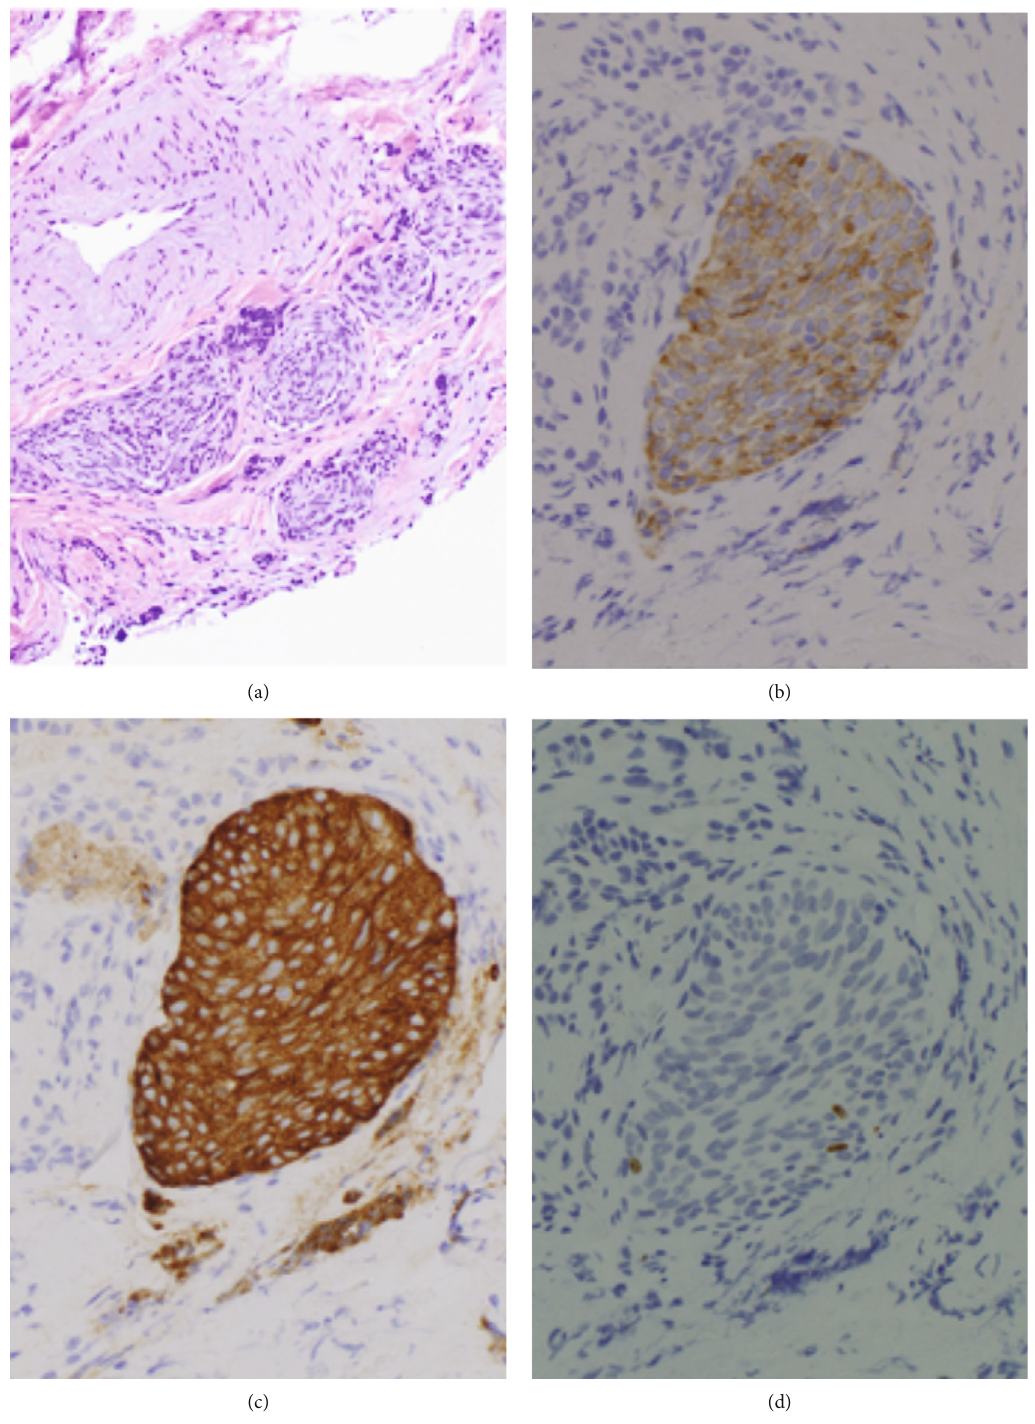
Figure 3: (a) H&E stain of the medial right middle lobe nodule. (b) Medial right middle node nodule with chromogranin-positive pathology, a neuroendocrine marker. (c) Medial right middle lobe nodule with synaptophysin-positive pathology, another marker for neuroendocrine cells. (d) Medial right middle lobe nodule with a Ki-67 proliferation marker with only 3 nuclei staining